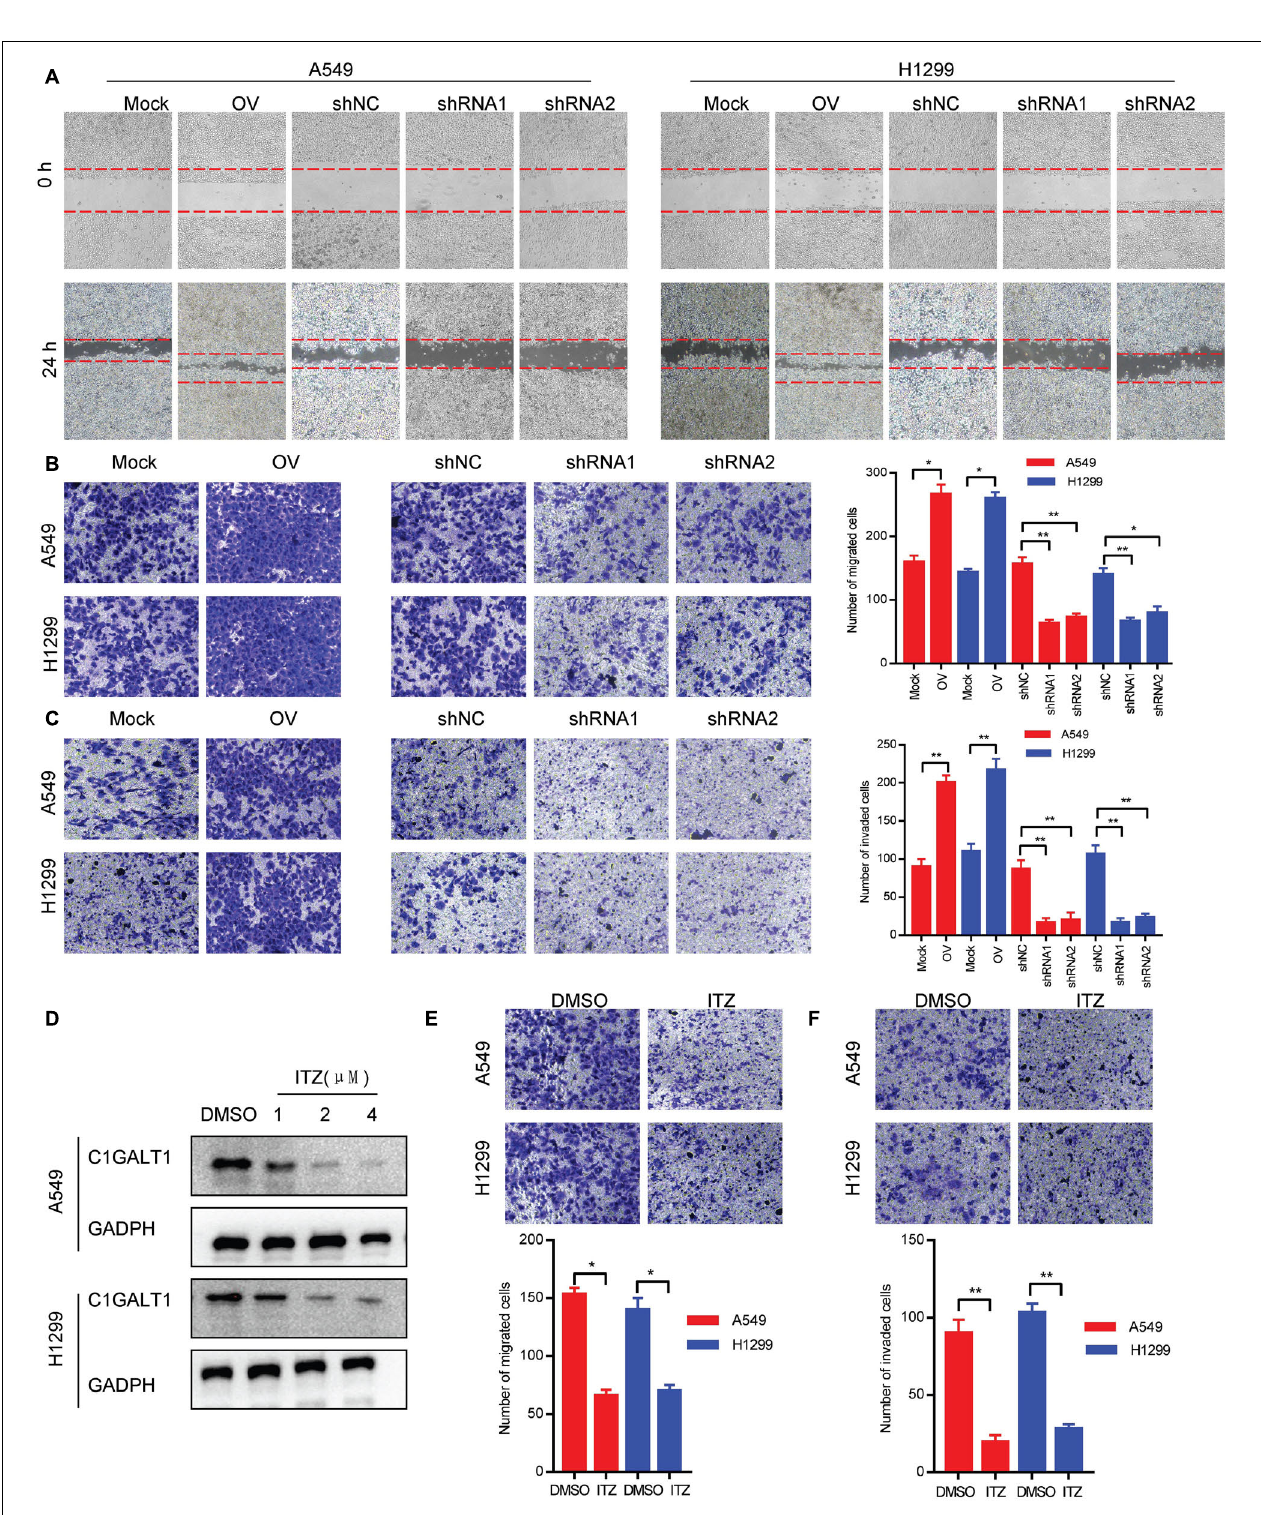
FIGURE 3 | C1GALT1 promotes LUAD cell migration and invasion in vitro. (A,B) The effect of C1GALT1 on cell migration was measured by wound-healing assay (A) and Transwell migration assay (B) . (C) The effect of C1GALT1 on cell invasion was determined by Matrigel invasion assay. (D) Analysis of C1GALT1 expression by Western blot after treatment with itraconazole (ITZ) for 48 h. (E,F) The effect of itraconazole (2 µ M) on cell migration and invasion was assessed by Transwell migration assay (E) and Matrigel invasion assay (F) . Mock, cells transfected with empty plasmid; OV, cells transfected with C1GALT1 overexpression plasmid; shNC, cells infected with negative control shRNA; shRNAs, cells infected with C1GALT1 shRNA. Data are expressed as mean ± SD. * p < 0.05; ** p < 0.001.